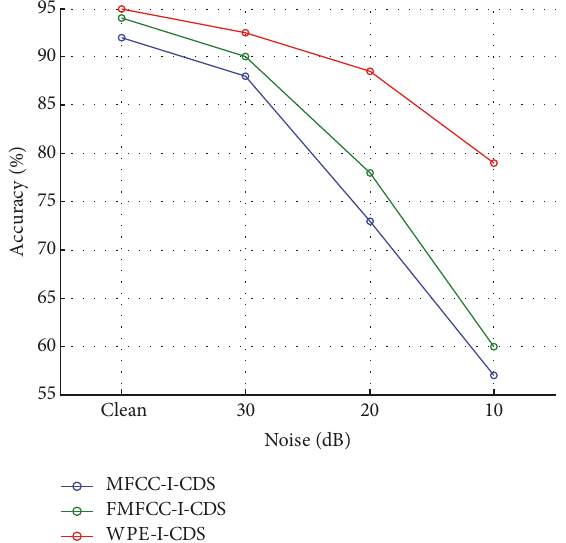
Figure 5: The accuracy of the 3 models in noisy environment. accuracy of the three models decreases by about 4%. This